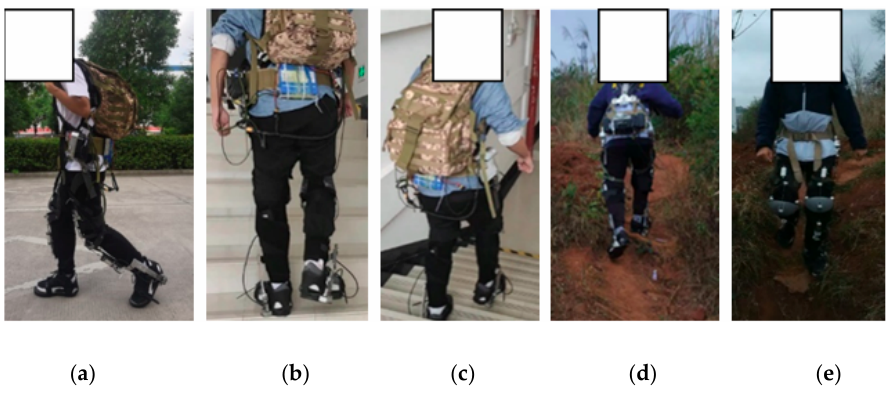
Figure 2. Experiments of different locomotion modes. ( a ) Flat Walking; ( b ) Up the Stairs; ( c ) Down the Stairs; ( d ) Up the Ramp; ( e ) Down the Ramp.